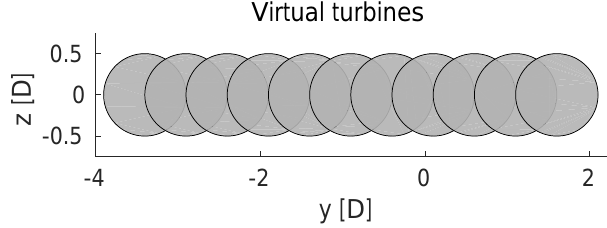
Figure 4. Illustrative sketch of the rotors of the virtual turbines con- sidered to assess the performance of the engineering models in re- lation to the large-eddy